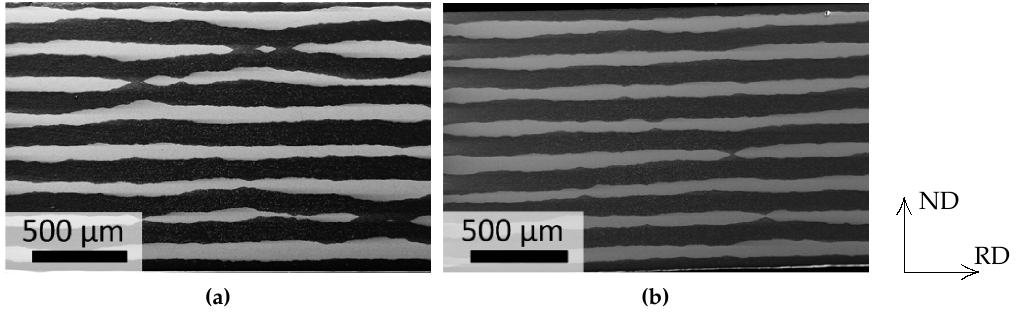
Figure 10. Cross-section of the layer structure after four ARB cycles in a trio ( a ) and four high rolling mill ( b ).